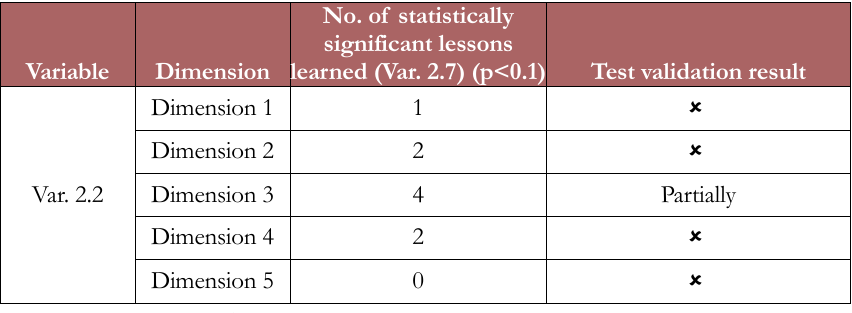
Table 6. Hypothesis 19